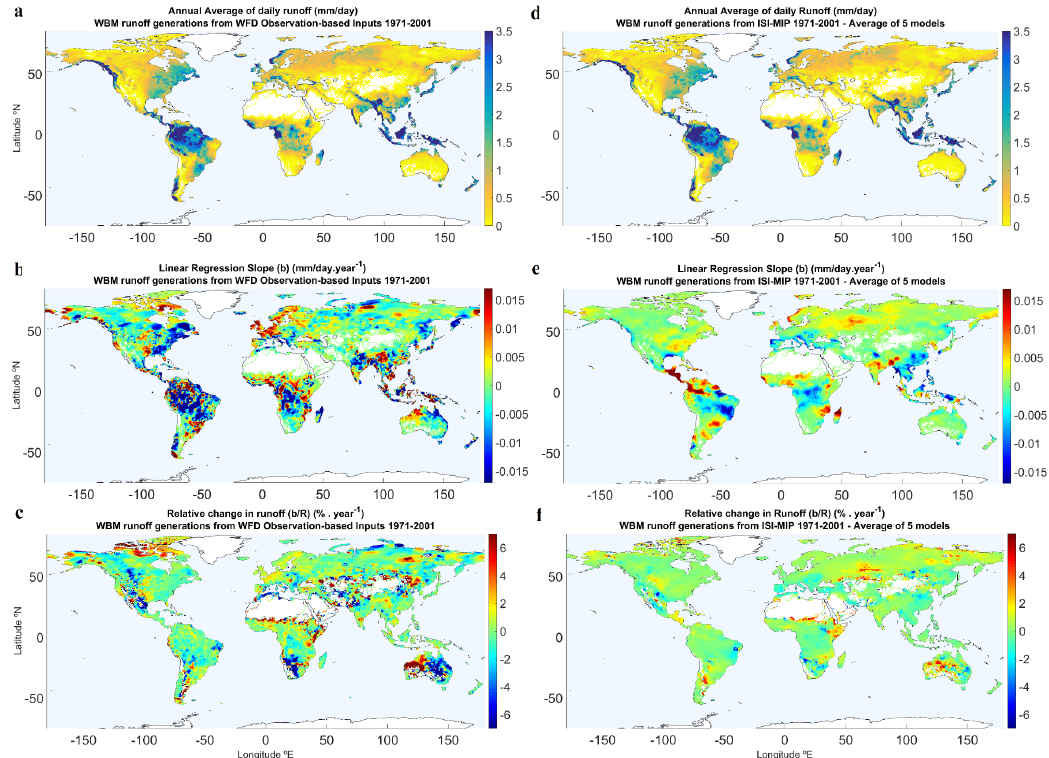
Figure 3. Global maps of runoff simulations of WBM model from WFD observation-based input versus ISI-MIP model simulations input, 1971–2001—Mean runoff map for WFD ( a ) and ISI-MIP ( d ), Slope of change in mean runoff map for WFD ( b ) and ISI-MIP ( e ), and relative change in mean runoff map for WFD ( c ) and ISI-MIP ( f ). Lower side axes of the maps represent the latitudeand left side axes represent the longitude of the girds.